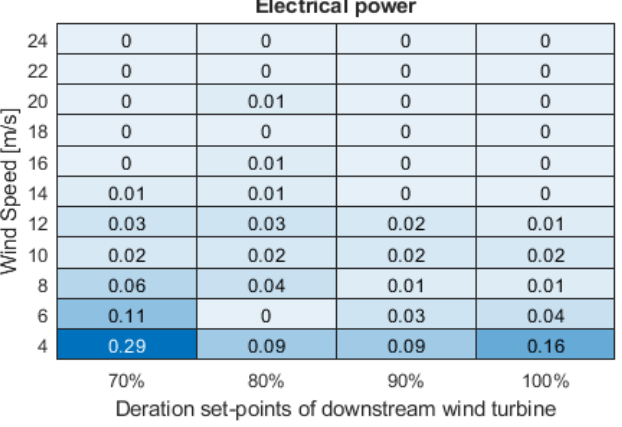
Figure 9. Test error of GPR electrical power of different deration set-points of downstream wind turbines ( x -axis) at I ref = 0.12 with normal operating upstream wind turbine. The model was trained and tested by all input data